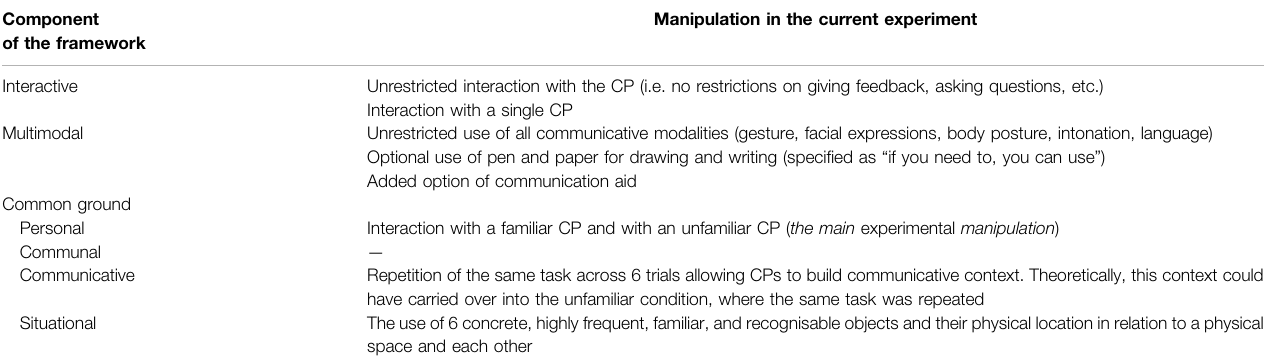
Manipulation in the current